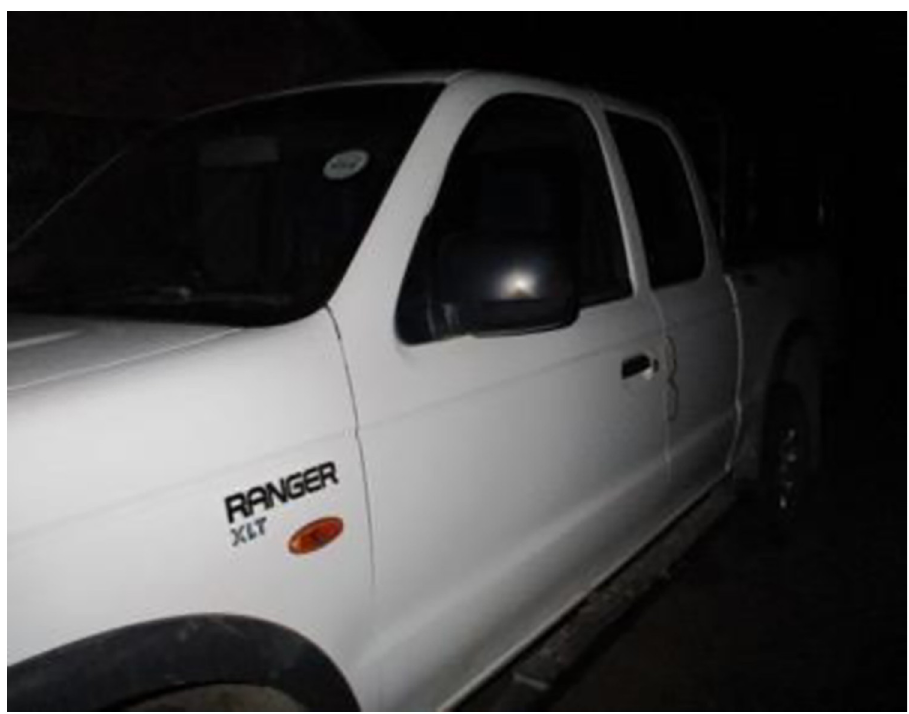
Fig 5. Image from co researcher 42–18.